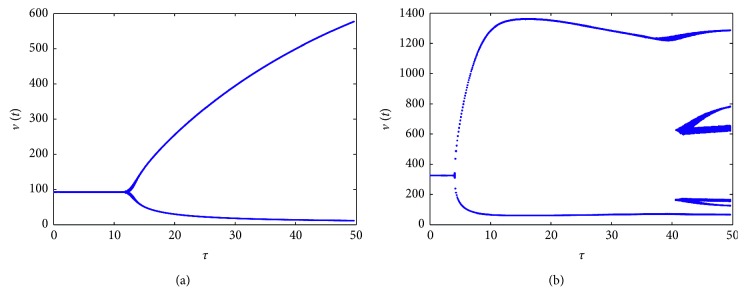
Bifurcation diagrams for model (1) with Hattaf–Yousfi response. (a) s=15, c=1, d
1=0.01, d
2=0.03, β
1=0.5, β
2=0.3, a
1=1, a
2=1, and a
3=1. (b) s=20, c=1, d
1=0.1, d
2=0.3, β
1=0.02, β
2=0.03, a
1=0.01, a
2=0.3, and a
3=0.001.